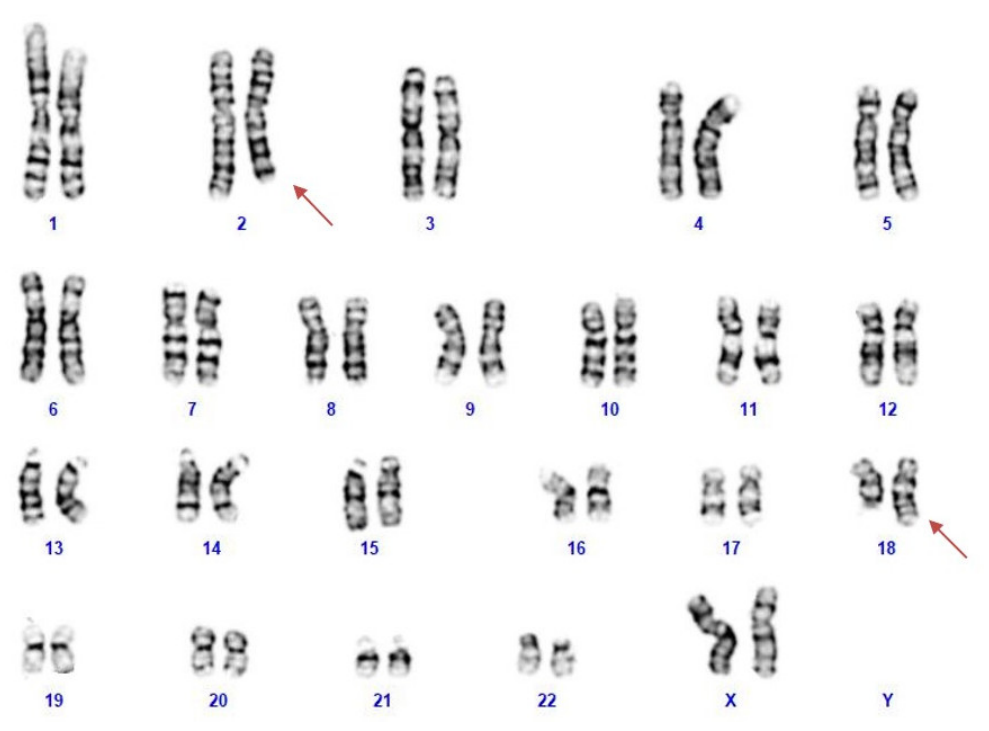
Figure 1. The patient’s karyotype showing a reciprocal translocation between the long arm of chromosomes 2 and 18.